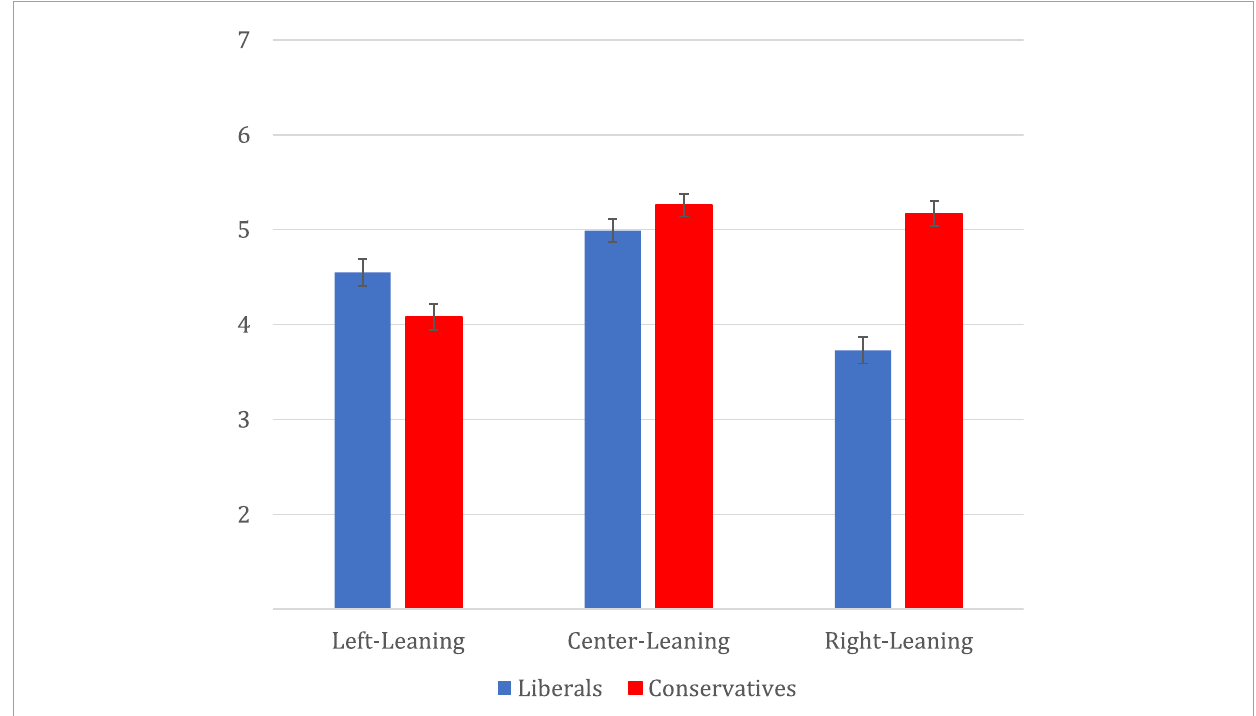
FIGURE2 Mean likelihood ratings of choosing left, center, or right-leaning articles by political ideology. Error bars represent standard